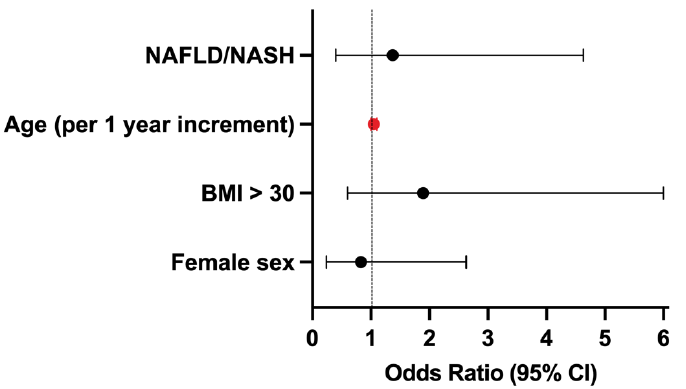
Figure 4. Predictors of advanced fibrosis at the first examination. CI, confidence interval. The sig- nificant predictor is depicted in red.